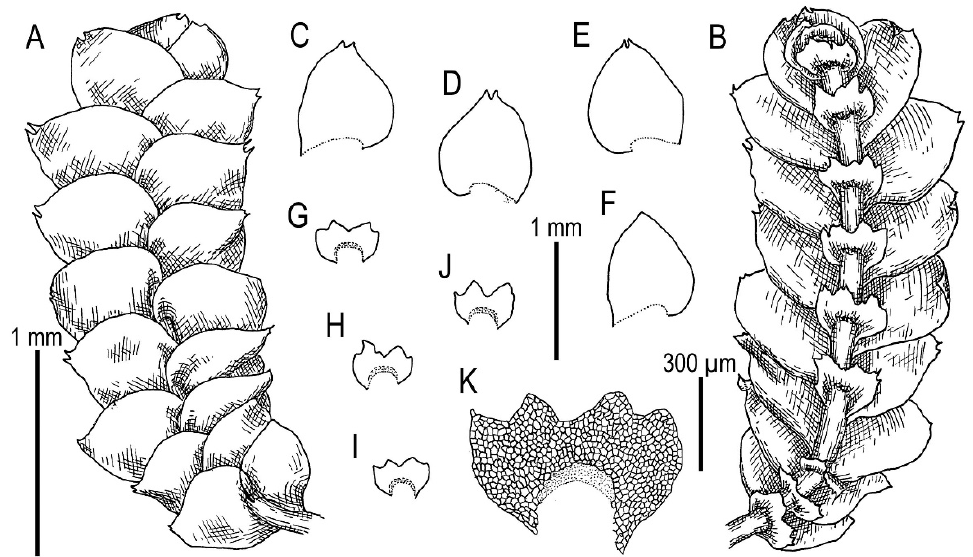
Figure 9. Calypogeia granulata Inoue: ( A ) Plant habit, fragment, dorsal view; ( B ) Plant habit, fragment, ventral view; ( C – F ) Leaves; ( G – K ) Underleaves. All from V-8-67-17 (VBGI).